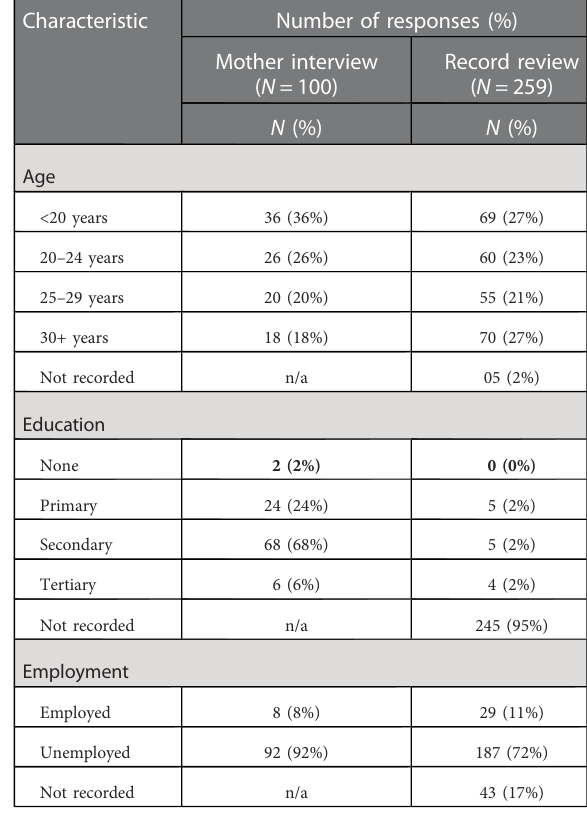
TABLE 2 Proportion of women assessment report, staff – client interactions, and overall satisfaction with care.